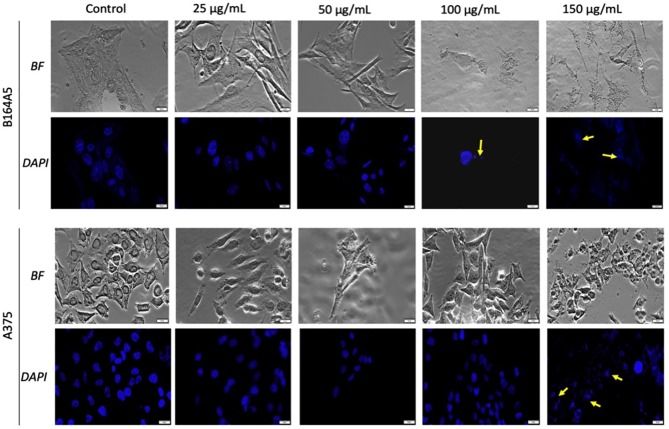
Melanoma - B164A5 and A375 cells treated with SCMIOPs at different concentrations (25, 50, 100, and 150 µg/ml) for 24 h. Bright field (BF) microscopy was employed to analyze morphological changes; DAPI staining (blue) was performed to evaluate cell nuclei modifications. Scale bars represent 20 µm.